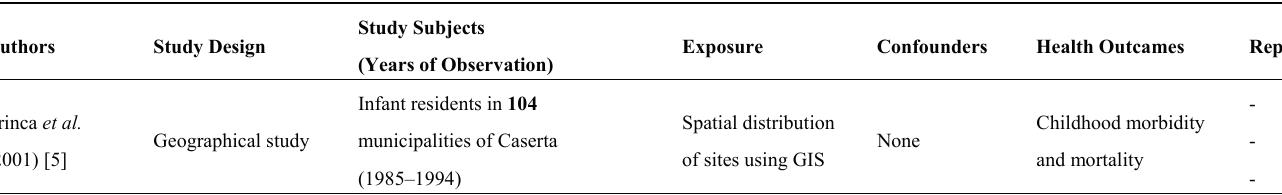
Table 1. Summary table of studies on health